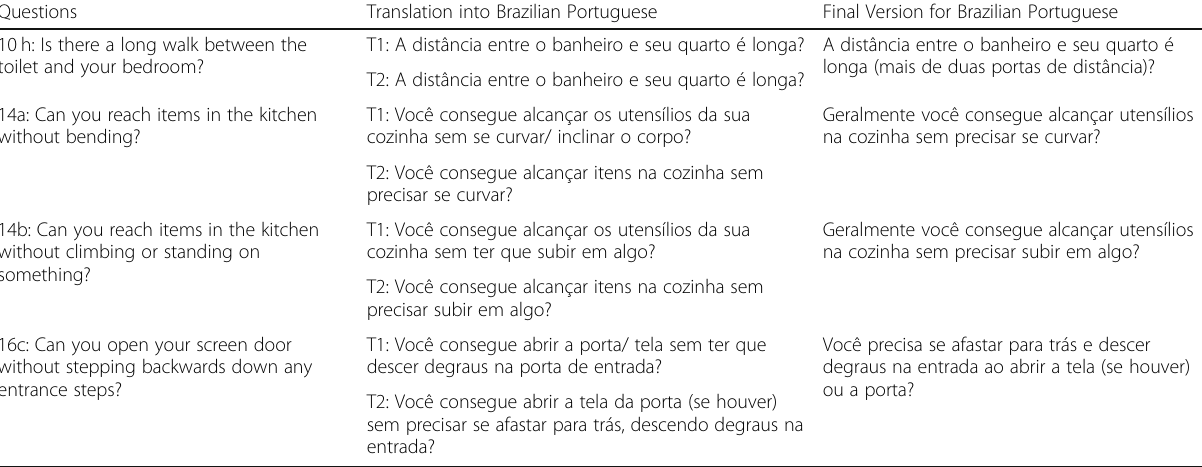
Table 2 Changes Performed After Pre-Final Version Application, Curitiba, PR, Brazil, 2017 Questions Translation into Brazilian Portuguese Final Version for Brazilian Portuguese